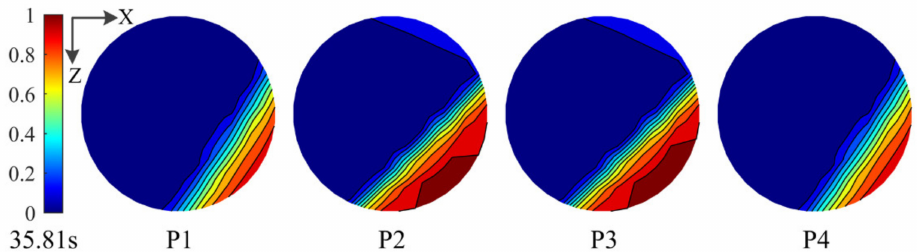
Figure 13. The compression damage of concrete in the core area at 34.63 s.